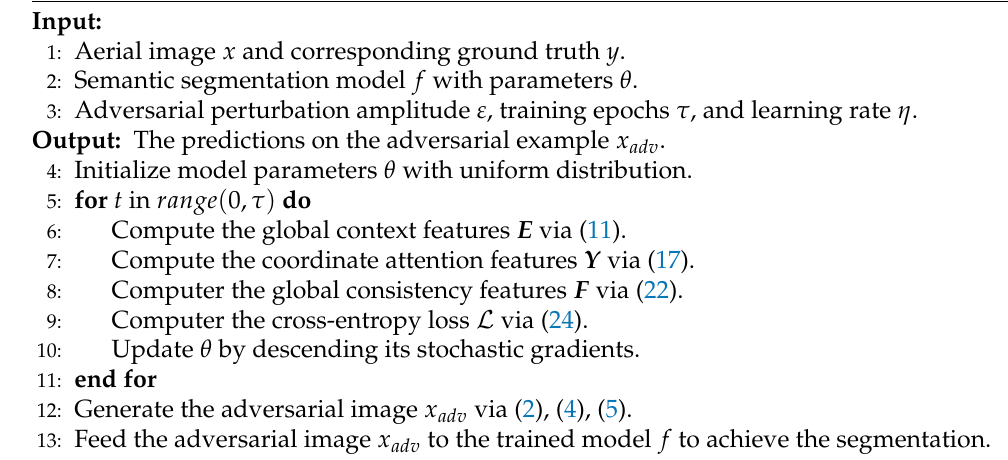
Algorithm 2 Adversarial Attack on GFANet.